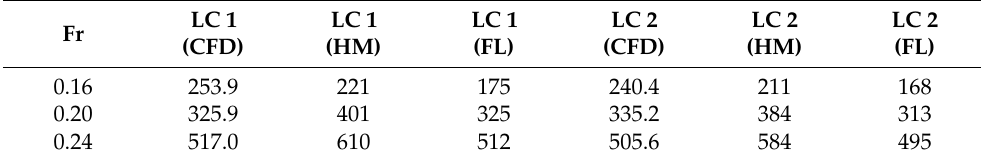
Table 5. Values of bare hull resistance in kilonewtons (kN) for CFD computations, Holtop and Table 4. Details of unstructured mesh sizes applied to computational domain for CFD computation. Mennen’s and Fung and Liebman